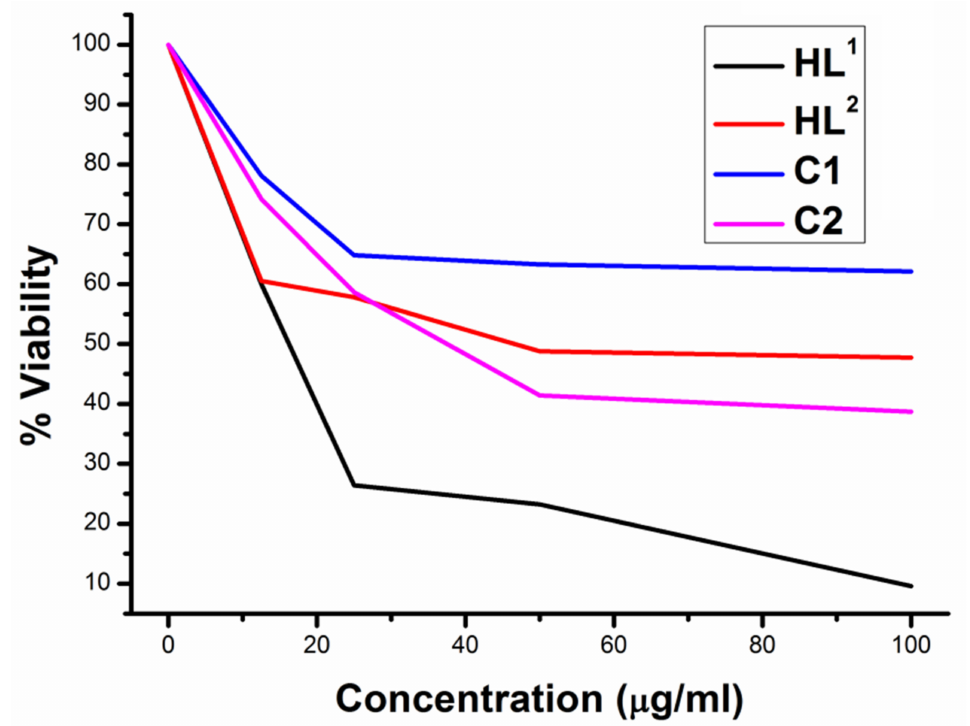
Figure 9. Anti-proliferative activities displayed by various concentrations of ligands ( HL 1 and HL 2 ) and complexes ( C1 and C2 ) against MCF-7 cancer breast